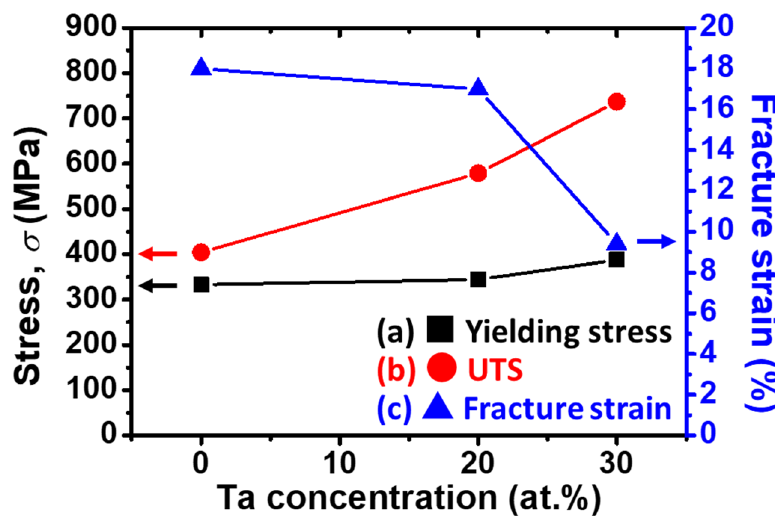
Figure 5. Functional mapping of ( a ) yielding stress (black squares), ( b ) ultimate tensile strength (UTS) (red circles), and ( c ) fracture strain (blue triangles) as a function of the Ta addition concentration in the alloys. (Left y –axis: stress (MPa); Right y –axis: fracture strain (%)) (Note that the results of the binary Ti–4Au alloy was cited from our preliminary research [35]).